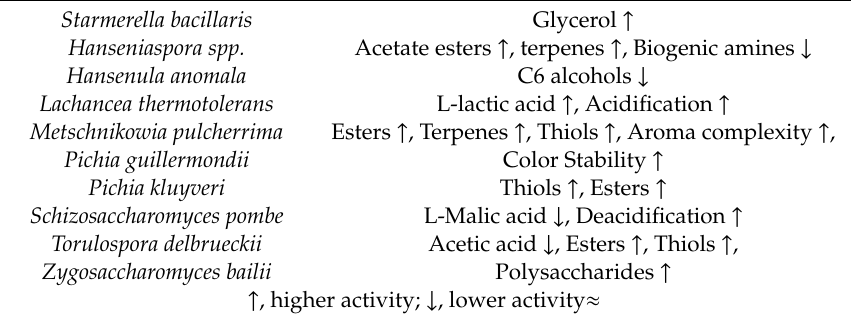
Table 1. Influence of non- Saccharomyces species on winemaking quality parameters. Starmerella bacillaris Glycerol ↑ Hanseniaspora spp.